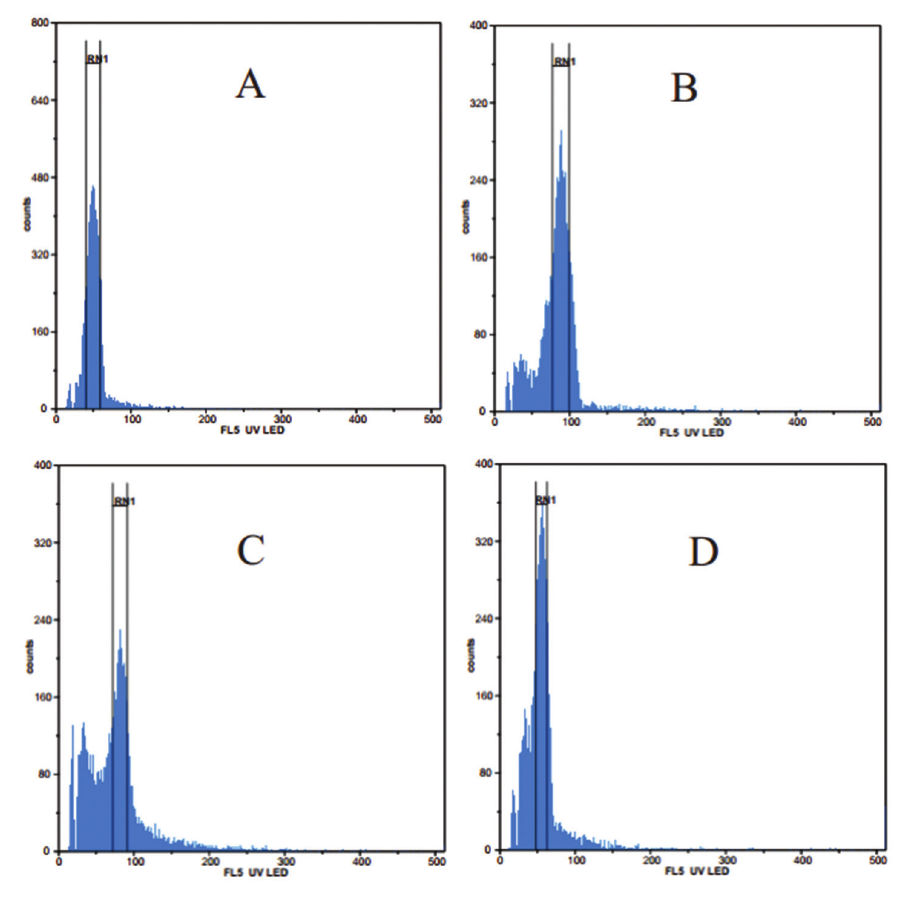
Figure 4. Histogram of relative DNA content of nuclei isolated from the leaves of the new plant and re- lated Hedychium species. A H. coronarium (control) B H. viridibracteatum C H. villosum var. tenuiflorum D H. villosum var. villosum